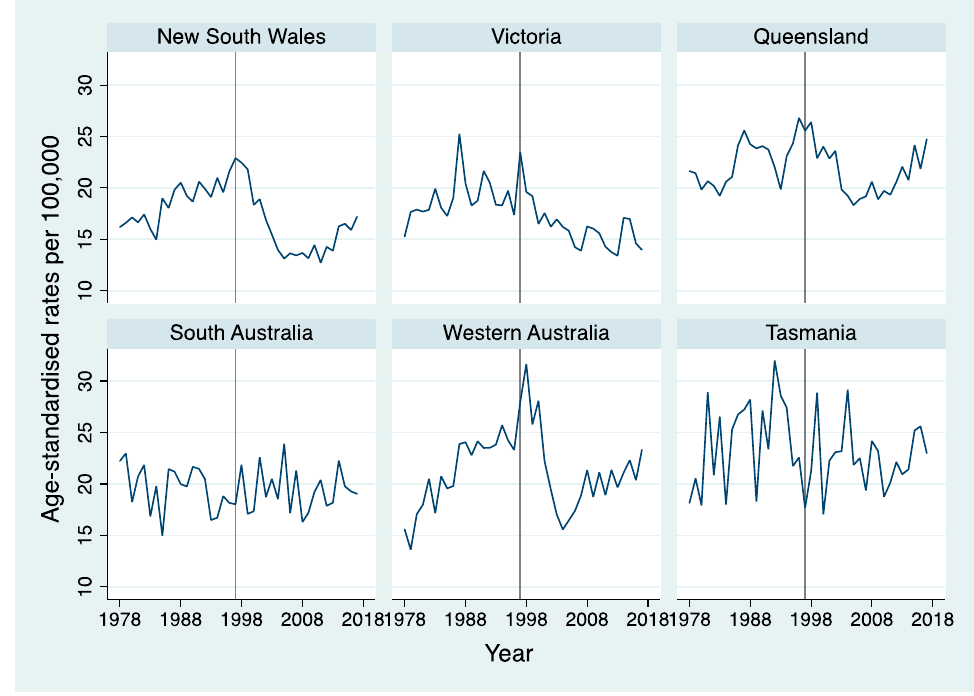
Figure 1. Age ‐ standardised overall suicide mortality rate per 100,000 by state among men. The grey line in 1997 represents the year when National Firearms Agreement was introduced in Australia and separates the 40 ‐ year study period into two halves.